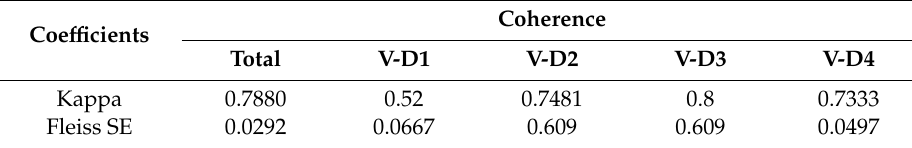
Table 2. Cohen’s Kappa values for inter-rater variability on the scale of Coherence. Coe ffi cients